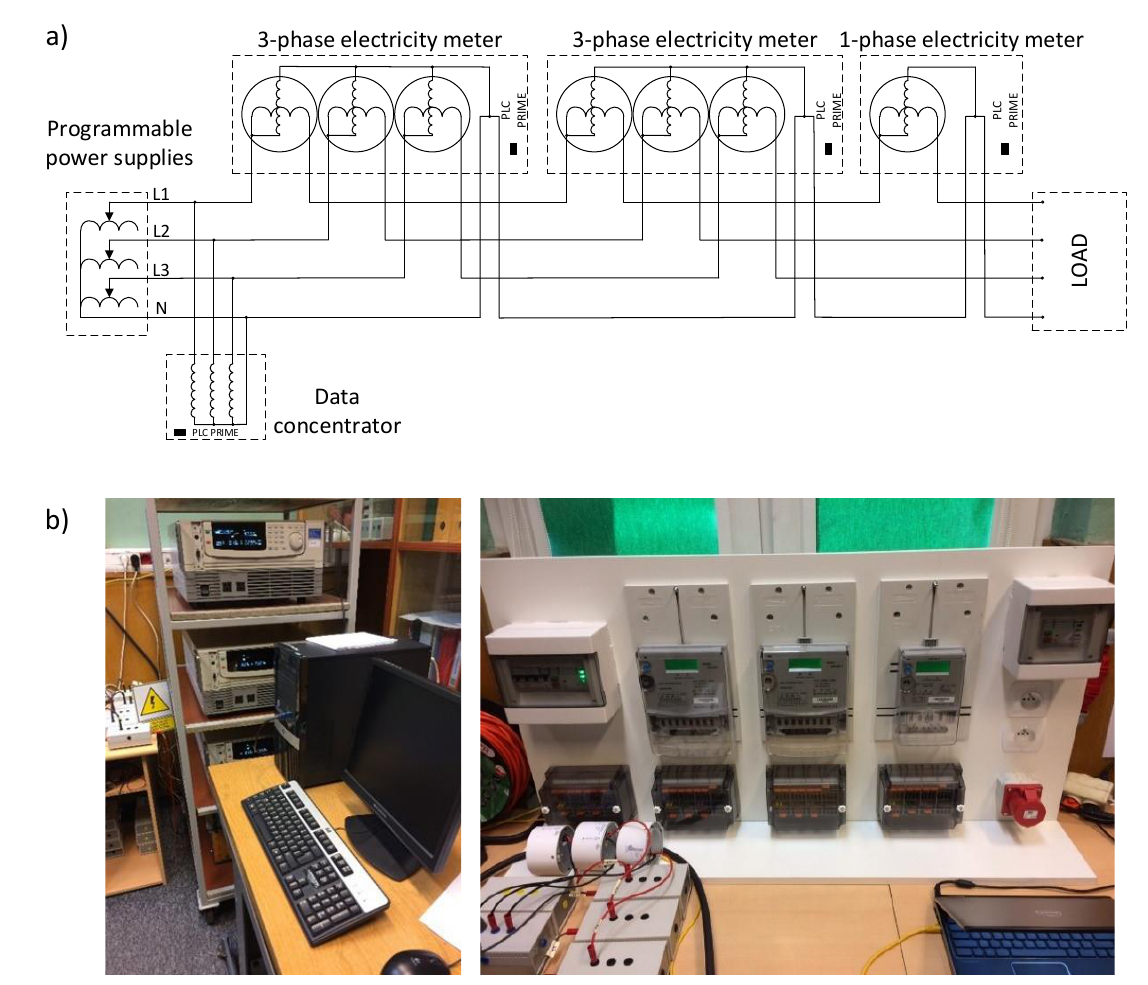
Figure 4. The laboratory setup: ( a ) electrical diagram of the test stand, ( b ) view of the power supply system in the form of programmable AC power supplies and model with power line communication (PLC) meters.